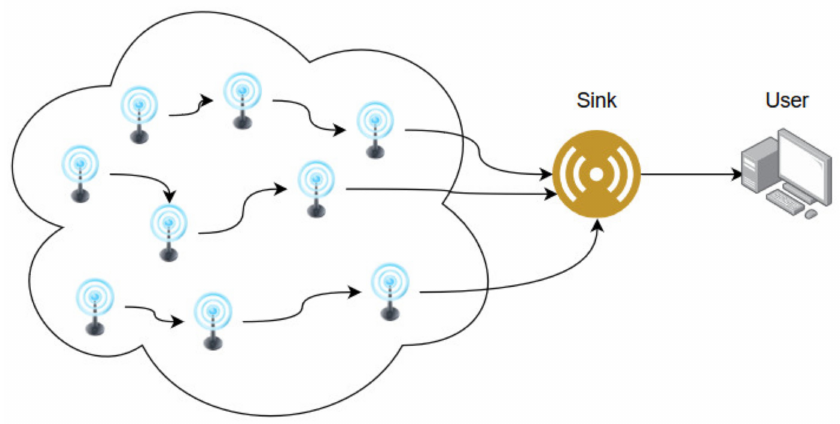
Figure 1. Traditional WSN